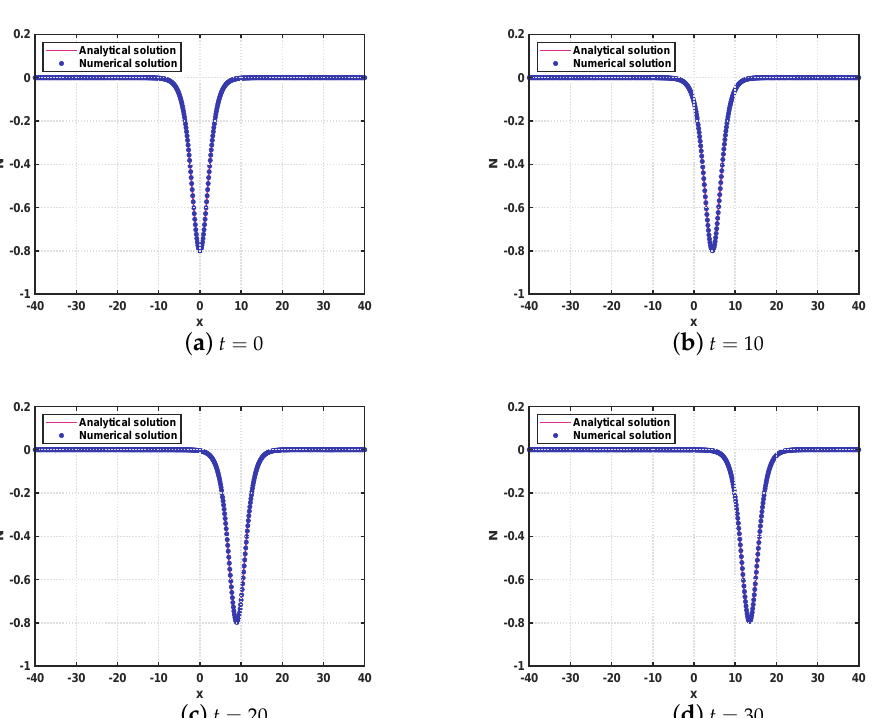
Figure 2. Comparison between numerical solution N f ( • ) and analytical solution N ( − ) with = 1 τ = τ C and h = 1 at different points in time for Case 1 of Example 8 4 100